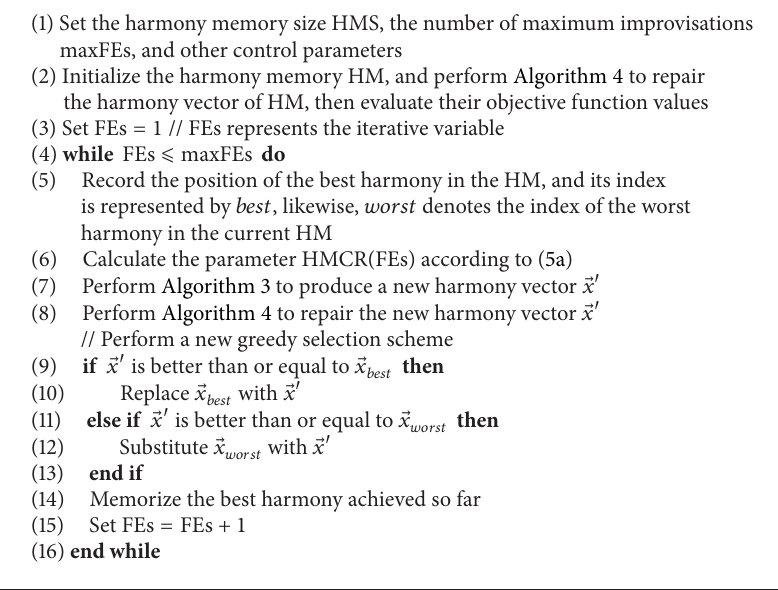
Algorithm 5: The DGHS algorithm.